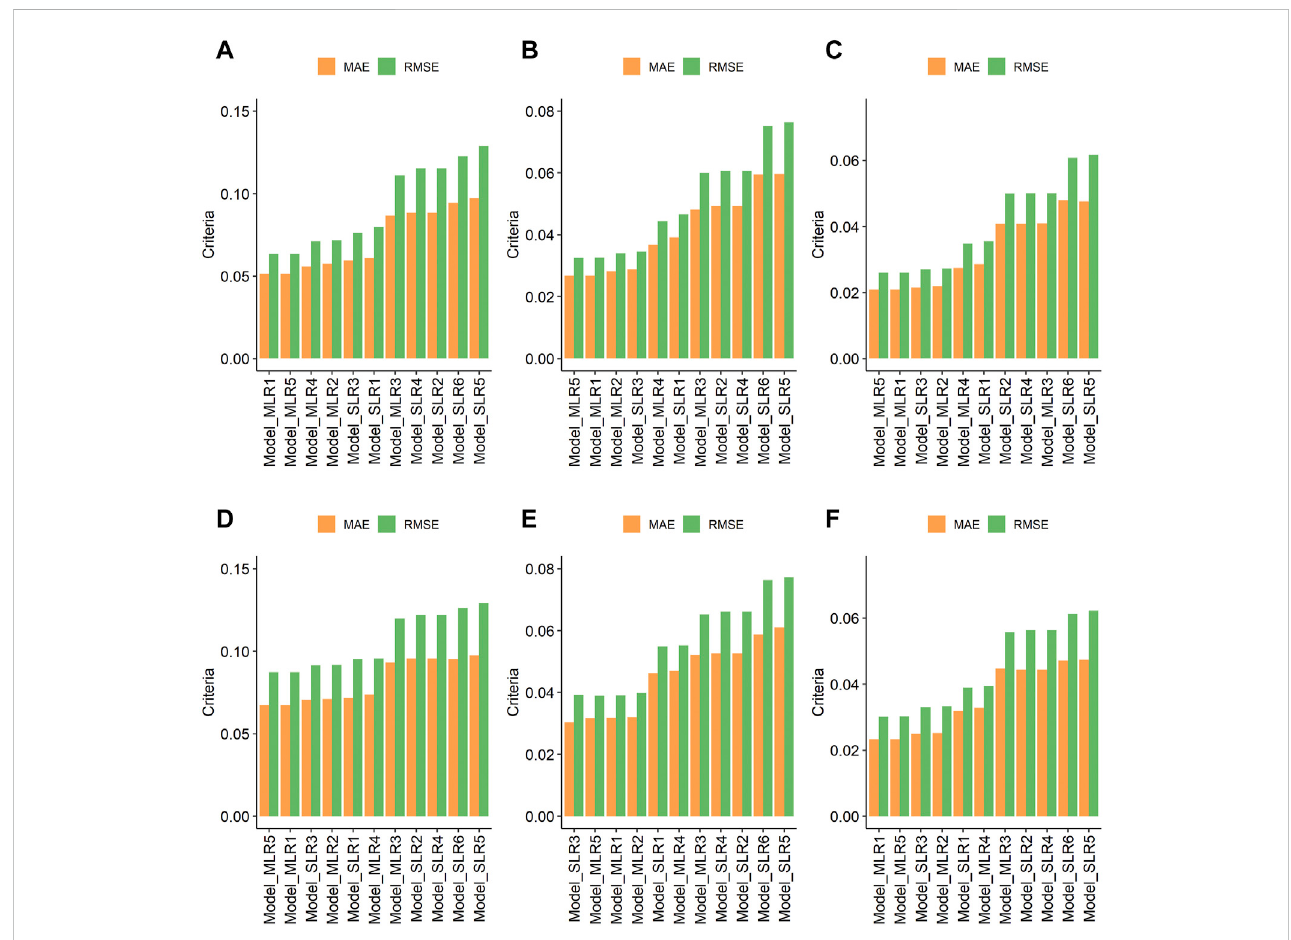
FIGURE 5 Comparison between RMSE (root mean square error) and MAE (Mean absolute error) for pedotransfer functions tested using simple linear regression (Model_SLR1 to Model_SLR6) and multiple linear regression (Model_MLR1 to Model_MLR5), for dataset based on fi eld data (A) : predicting w 0 ; (B) predicting w 330 ; (C) predicting w 15000 ), and for iSDAsoil data (D) : predicting w 0 ; (E) predicting w 330 ; (F) predicting w 15000